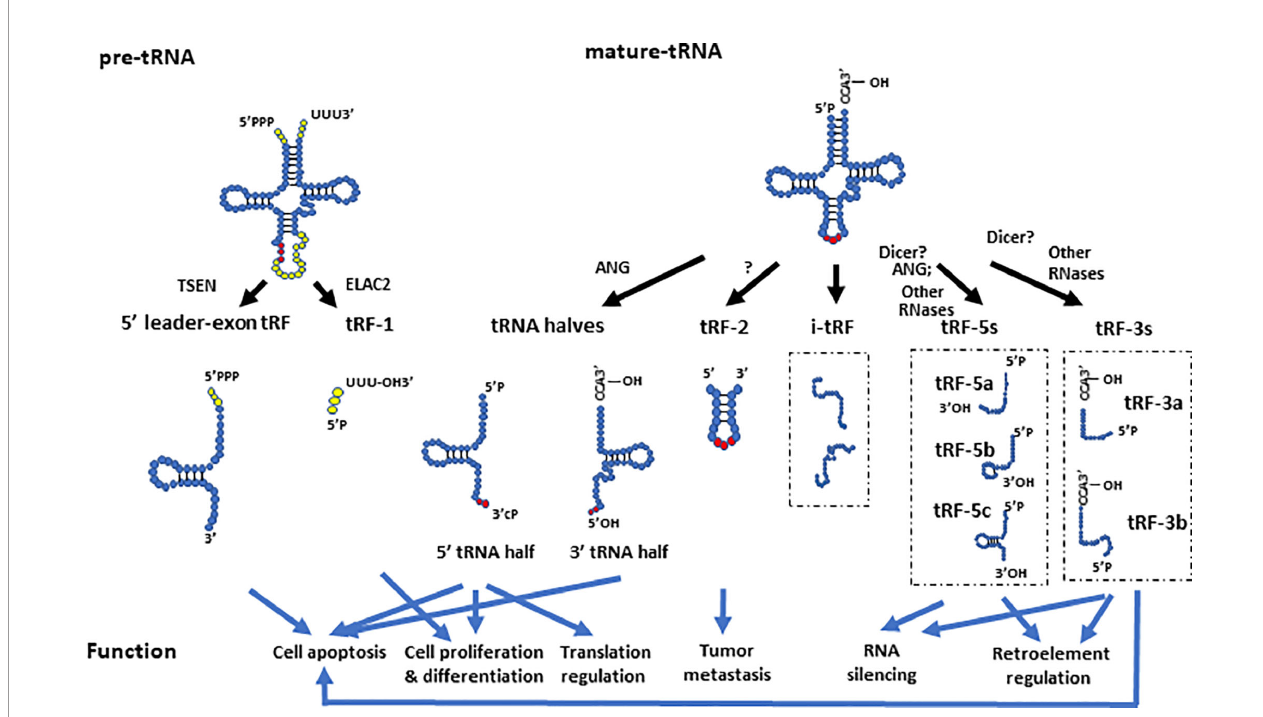
FIGURE 2 | The biogenesis and function of different tsRNAs derived from pre- and mature- tRNAs. The 5 ’ leader-exon tRFs and tRF-1s are generated from cleavage of pre-tRNAs by TSEN and ELAC2, respectively. The 5 ’ - and 3 ’ - tRNA halves are generated by cleavage of mature tRNAs at the anticodon region by ANG. tRF-2s contain anticodon stem and loop regions of mature tRNAs. The tRF-5 group includes tRF-5a, tRF-5b, and tRF-5c, which are generated by endonucleolytic cleavage of mature tRNAs at D loop, D stem, and the stem regions between the D stem and anticodon loop, respectively. The tRF-3 group includes the tRF-3a and tRF-3b subgroups, which are generated by endonucleolytic cleavage of mature tRNAs at different locations of their T arms. The i-tRFs are generated from internal parts of tRNAs, whose 5 ’ termini start from the second or subsequent nucleotide of mature tRNAs. They are usually about 36 nts in size, and have various subtypes. This fi gure only showed two examples of i-tRFs. The different tsRNAs contribute to a variety of molecular processes such as translational regulation, RNA silencing, and retro-element regulation. They are also involved in tumor metastasis, apoptosis, cell proliferation, and